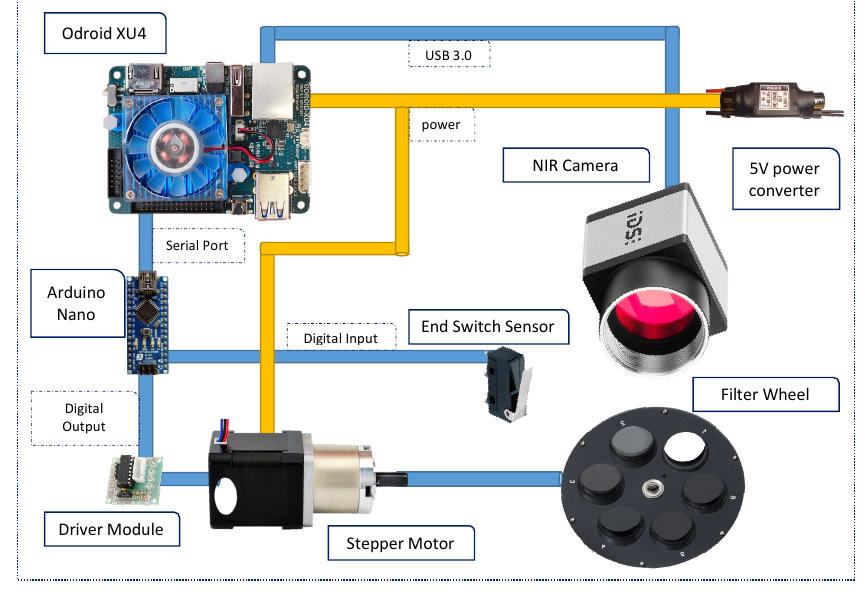
Figure 1. System